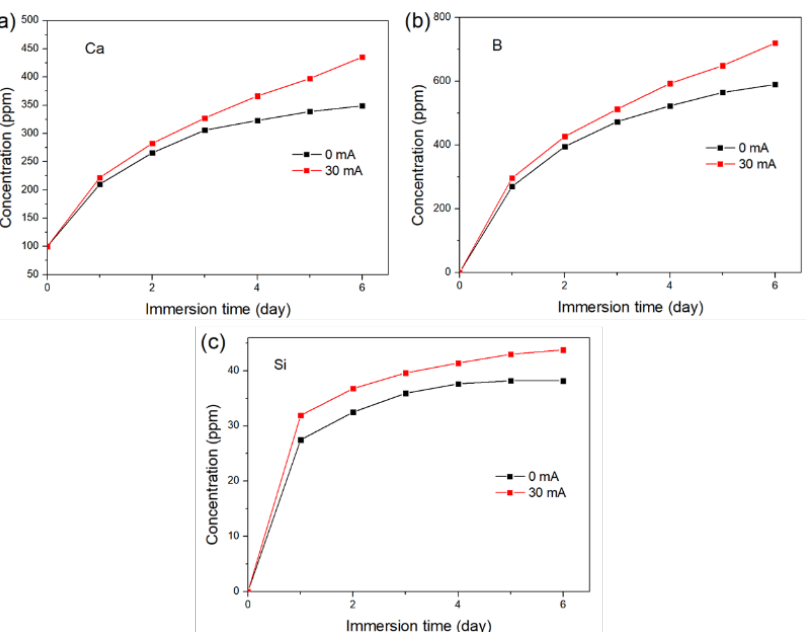
Figure 11. Time-dependent release of ( a ) Ca, ( b ) B, and ( c ) Si from the glass samples with and with- out a DC electric field applied for 6 days.